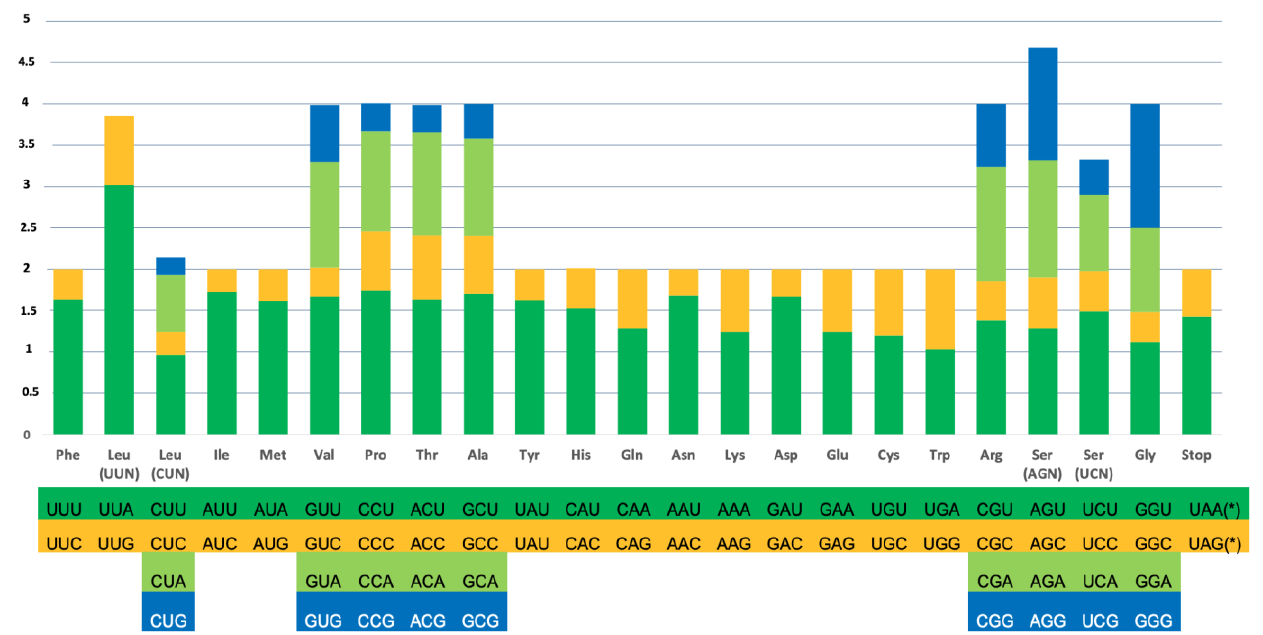
Figure 3. RSCU in the Pontastacus leptodactylus mitogenome. RSCU values are depicted on the y-axis while on the x-axis the codon families for amino acids and stop codons are shown. The asterisk “*” indicates the stop codon.